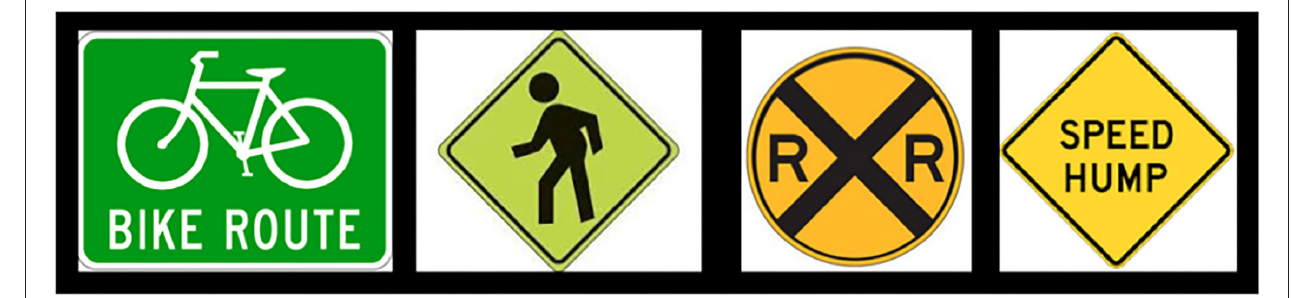
FIGURE 2 | Sample stimulus signs.